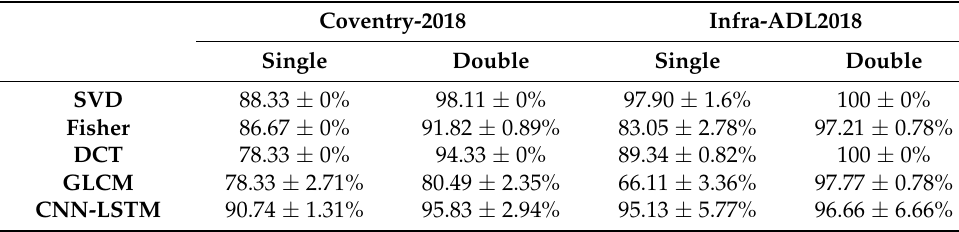
Table 5. Testing performances for all feature extraction methods and LR classifier as well as the CNN- LSTM method using the Sensor-1 large-layout dataset for 8 classes of single-subject and 7 classes of double-subject activities from the Coventry-2018 dataset, as well as 9 classes of single-subject and 10 classes of double-subject activities from the Infra-ADL2018